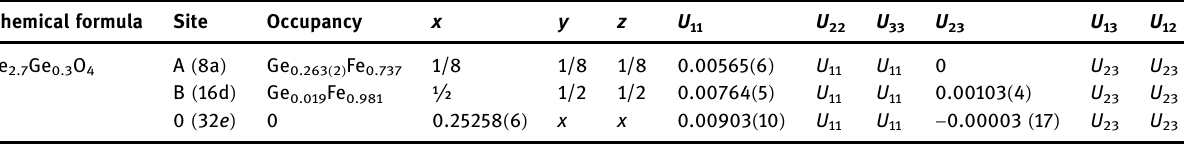
Table 2: Atomic coordinates and displacement parameters ( 10 − 2 nm 2 ) for Fe 2.7 Ge 0.3 O 4 Chemical formula